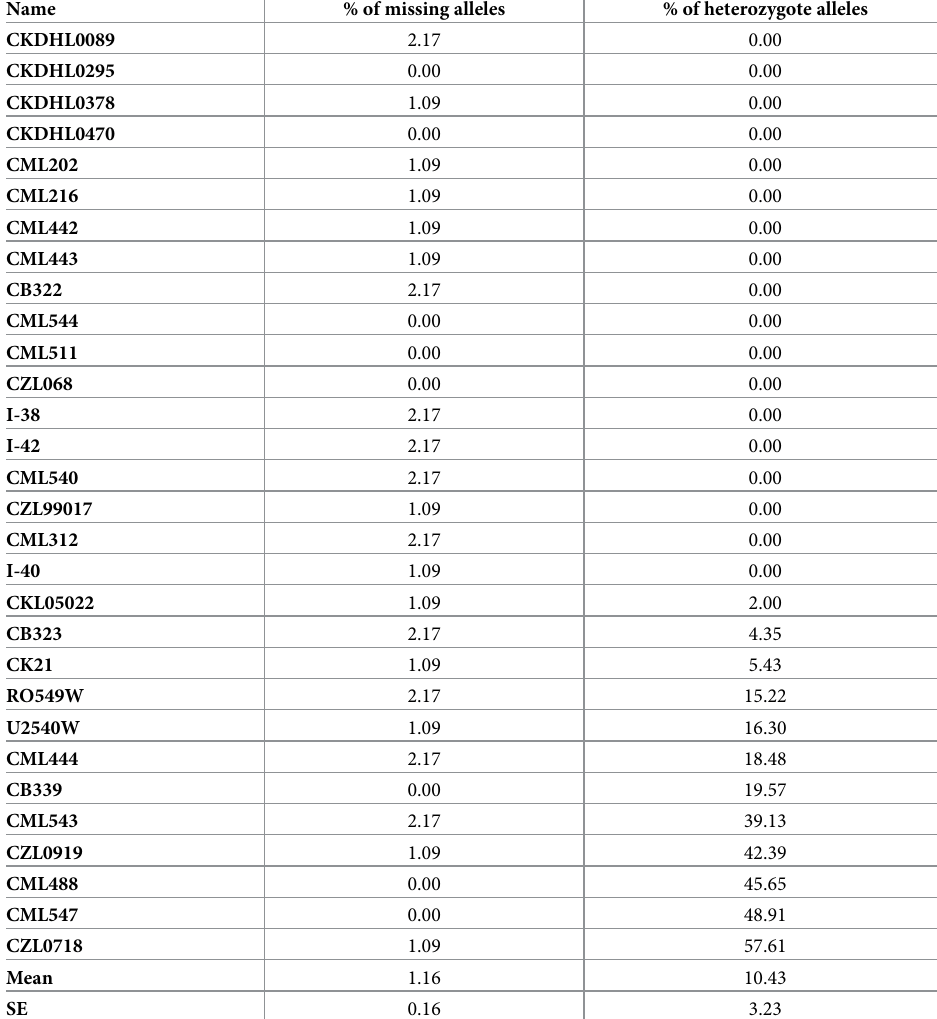
Table 2. Genetic purity of 26 maize inbred lines and four doubled haploid lines based on 92 SNPs.